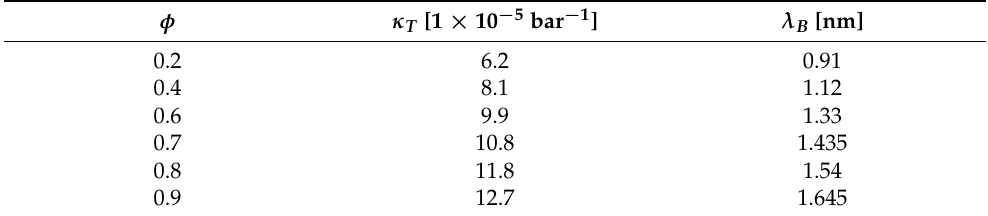
Table 3. The characteristics of mixed solvents (water plus methanol): the solvent compressibility κ